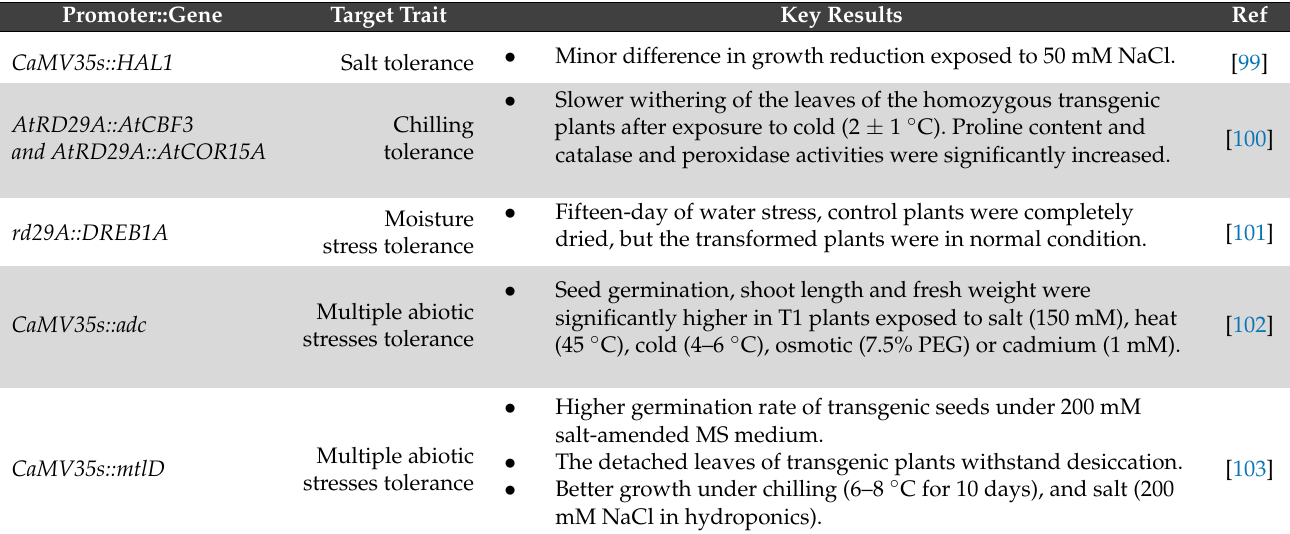
Table 5. List of abiotic stress-tolerant transgenic eggplant developed so